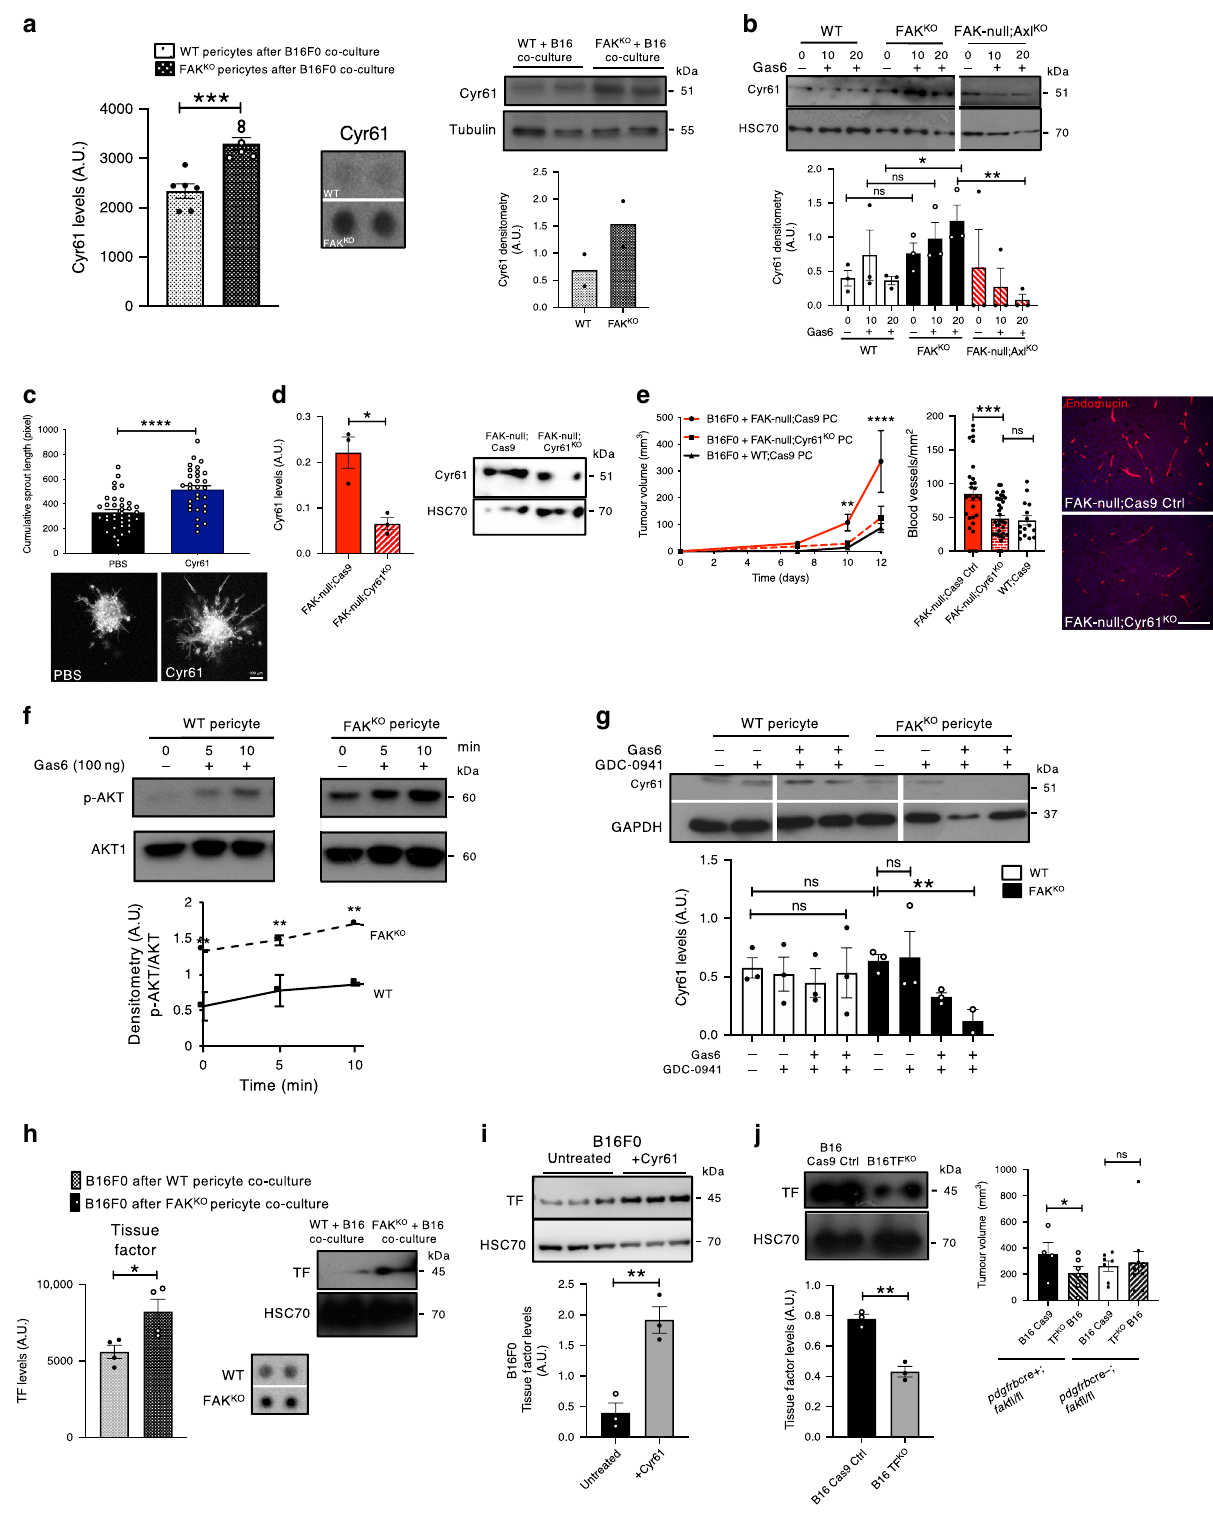
normalised to perfused blood vessel density stained with PE-PECAM (MEC13.3, 102507, Biolegend, 1:100). For blood vessel perfusion and blood vessel diameter measurements in tumours see Supplementary Methods.